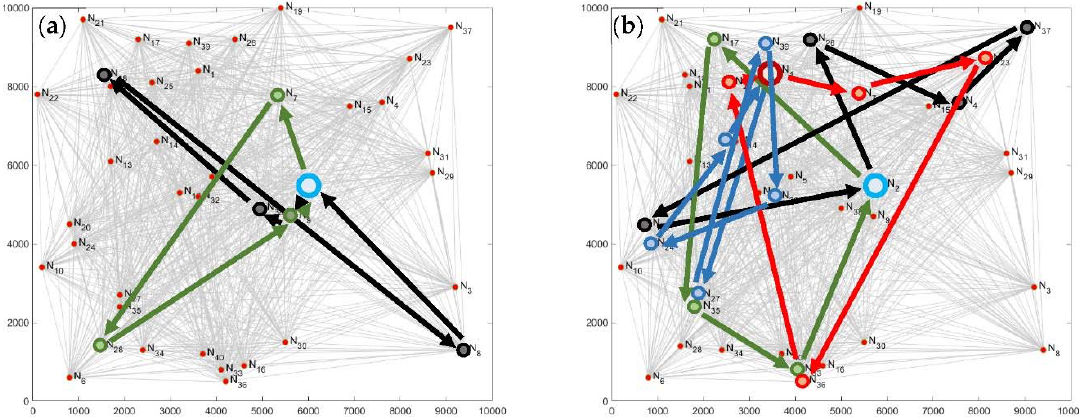
Figure 8. Two kinds of response on the occurrence of a disruption: ( a ) the reaction after a finished mission in the given time window (sub-mission 3 S ), ( b ) the “ad hoc” reaction (sub-mission 2 S ).